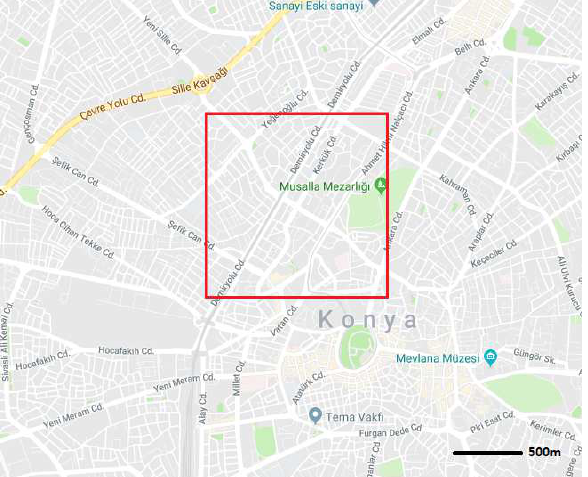
Figure 1. The study area. The centre is 37°53'2.4''N latitude and